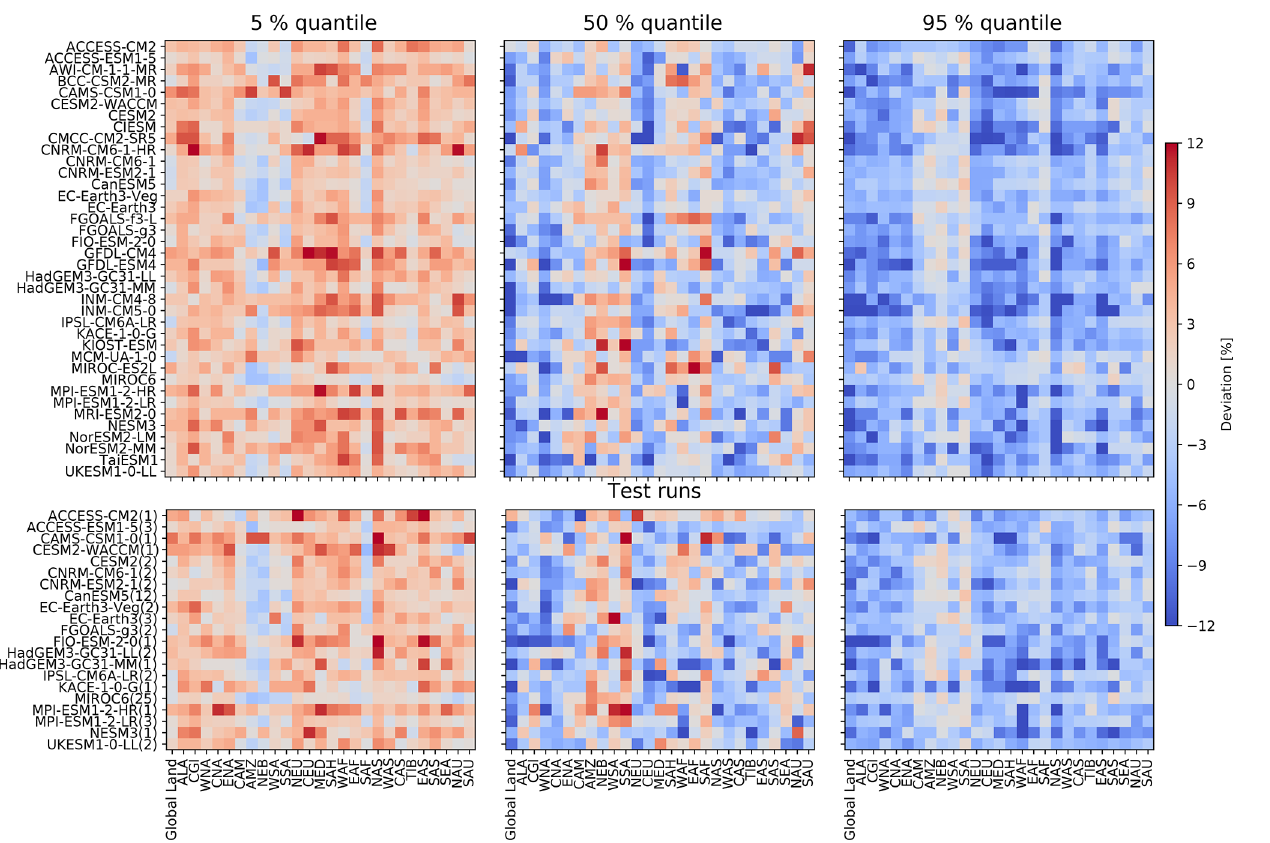
Figure 8. January 5% (left), 50% (middle), and 95% (right) quantile deviations (colour) of the climate model runs from the emulated quantiles of the ESM training (top block) and test (bottom block) run values from their monthly emulated quantiles, over the period 1870– 2000 for global land (without Antarctica) and SREX regions (columns) across all CMIP6 models (rows). The monthly emulated quantile is computed based on 50 emulations per ESM run, and quantile deviations are given as averages across the respective number of ESM training/test runs. The number of test runs averaged across is indicated in brackets next to the model names in the bottom block. Red means that the emulated quantile is warmer than the quantile of the ESM run and vice versa for